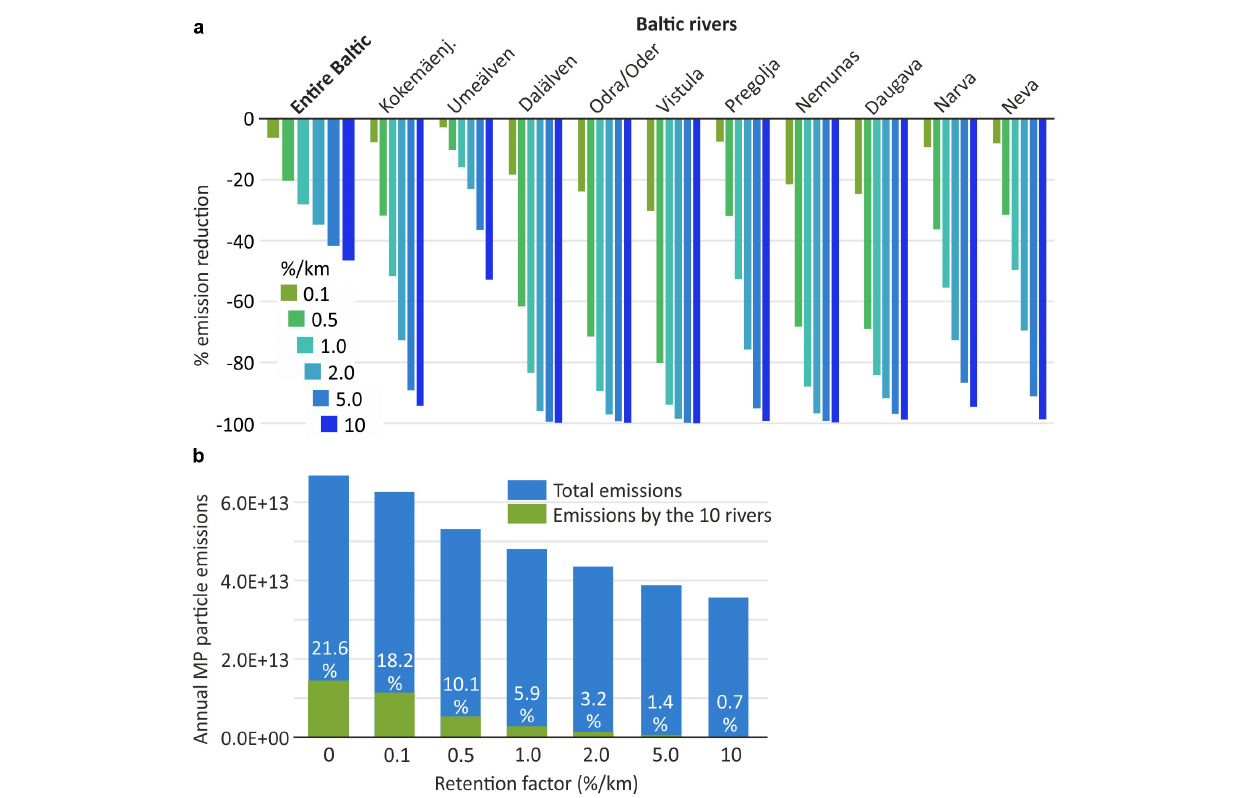
FIGURE 8 | (a) Relative reduction of annual micro-plastic particle emissions reductions (floating and sinking fraction, size class 20–500 µ m) to the Baltic Sea assuming different micro-plastics retention factors (%/km) in rivers, calculated for the entire Baltic Sea catchment and 10 selected rivers. The reduction is related to the present load of every river. (b) Absolute annual micro-plastics particle emissions resulting from increasing micro-plastic retention factors (%/km) in rivers as well as relative share of the 10 rivers compared to the total emissions to the Baltic Sea.